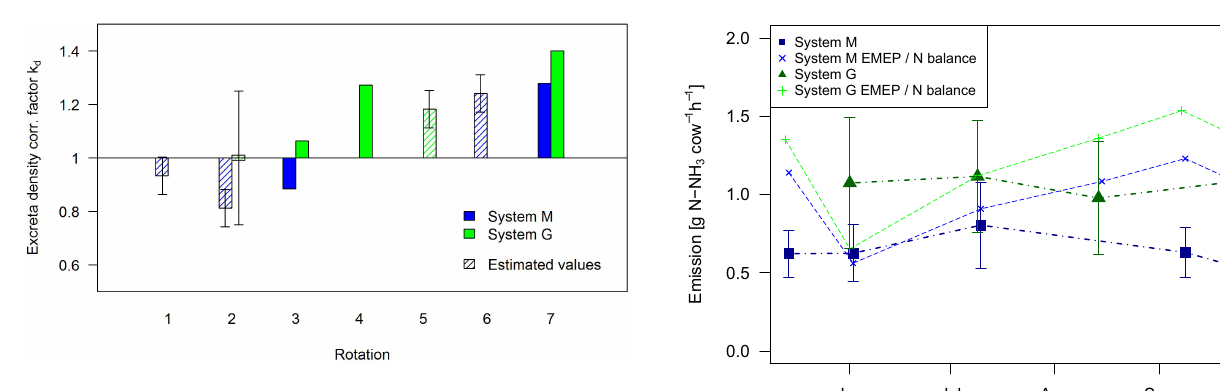
Figure 10. Correction factor k d (Eqs. 2, 3) of the excreta density for rotations with available emission results (Table 3). For the rota- tions without dung observations, the corresponding correction fac- tors (hatched bars) were estimated based on a regression analy- sis between parallel surveys of density anomalies for dung patches and cow positions (Fig. 3b). The error bars show the corresponding uncertainty of estimated k d values as described in Sect. 3.4.